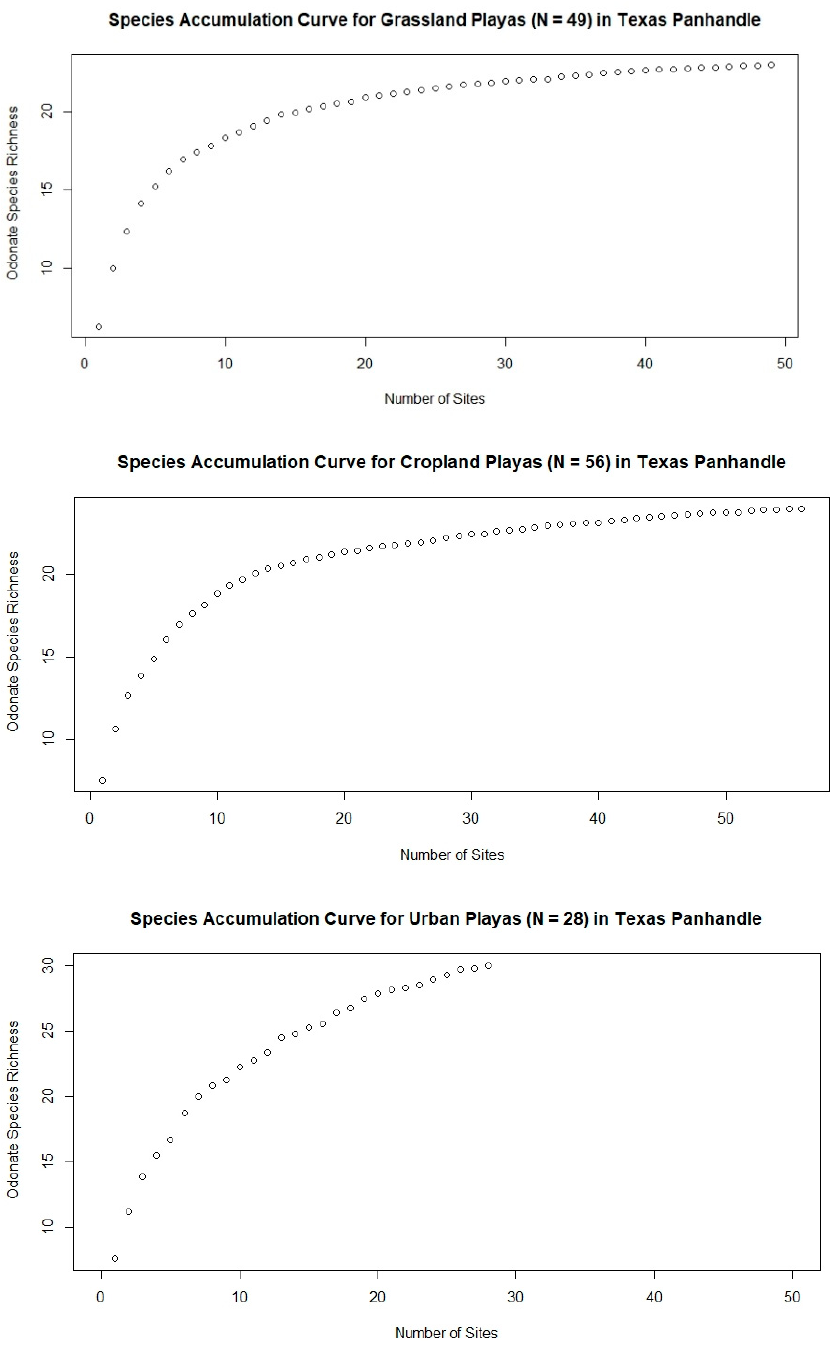
Figure 7. Species accumulation curves by surrounding land use/land cover. Table 2. Frequency of the occurrence of water in playas sampled in the Texas panhandle (United States), 2003–2020.